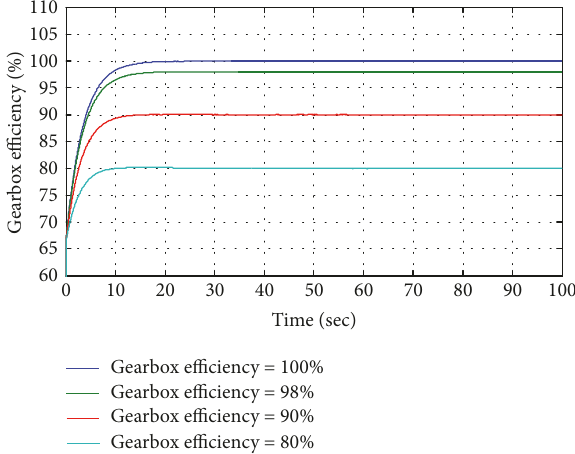
Figure 8: Estimation of gearbox efficiency 100%, 98%, 90%, and 80%.